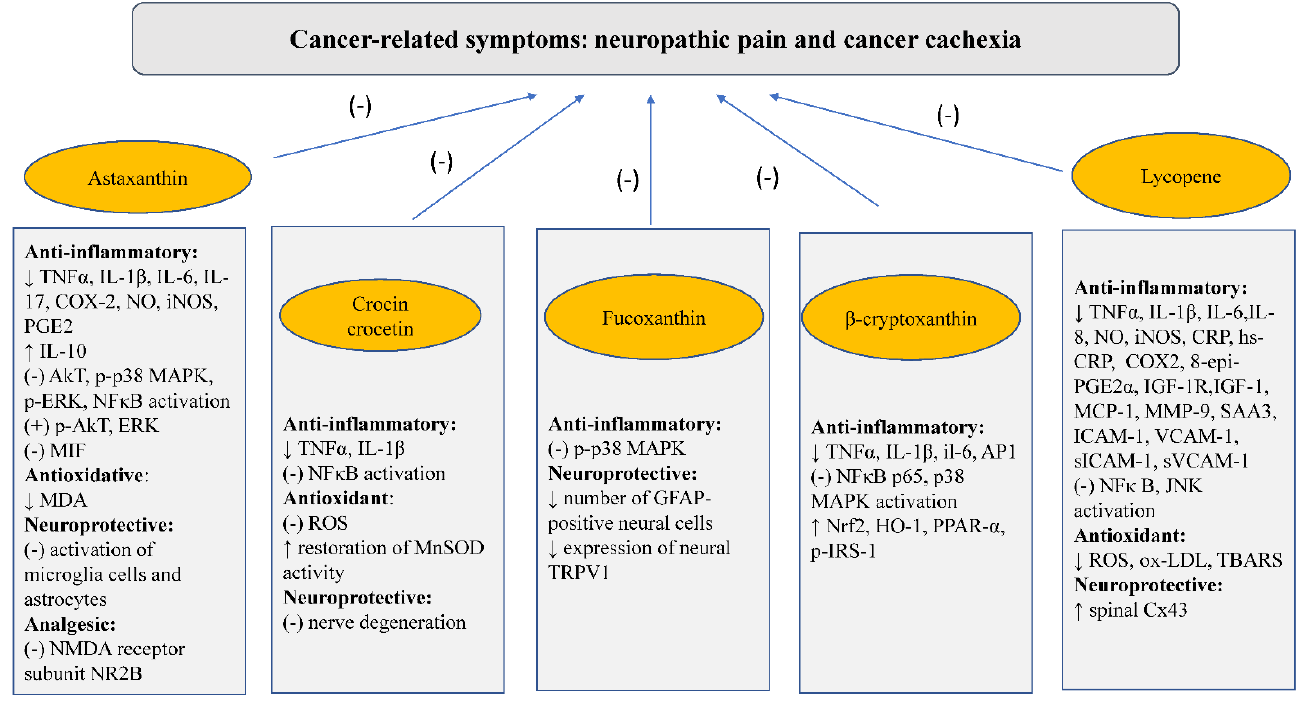
Figure 2. Mechanisms of carotenoids capable of relieving cancer symptoms: neuropathic pain and cachexia data obtained on the basis of the literature ( ↓ —reduction, ↑ —increase, ( − )—inhibition, (+)—intensification).